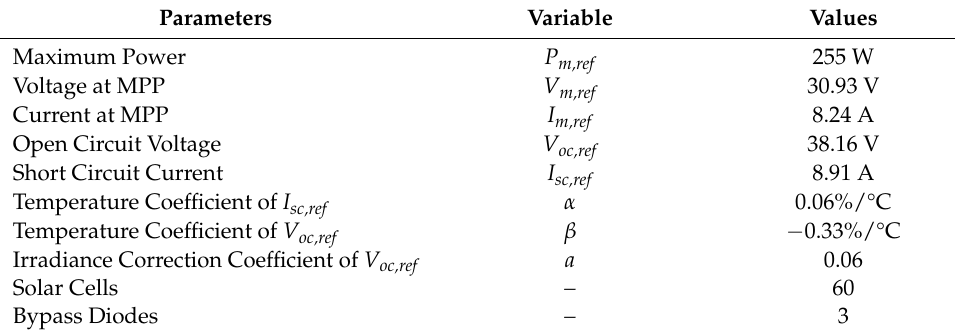
Table 1. The specification of PV (AEG AS-P603) module under STC. Parameters Variable Values Maximum Power P m,ref 255 W Voltage at MPP V m,ref I m,ref Open Circuit Voltage V oc,ref Short Circuit Current I